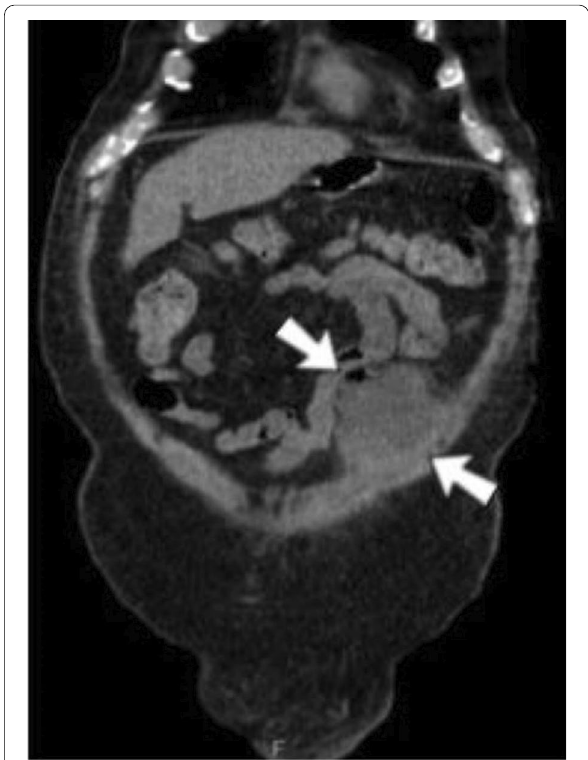
Fig. 1 Coronal plane CTAP without contrast showing complicated descending colonic diverticulitis associated with adjacent developing localized air leak and abscess formation